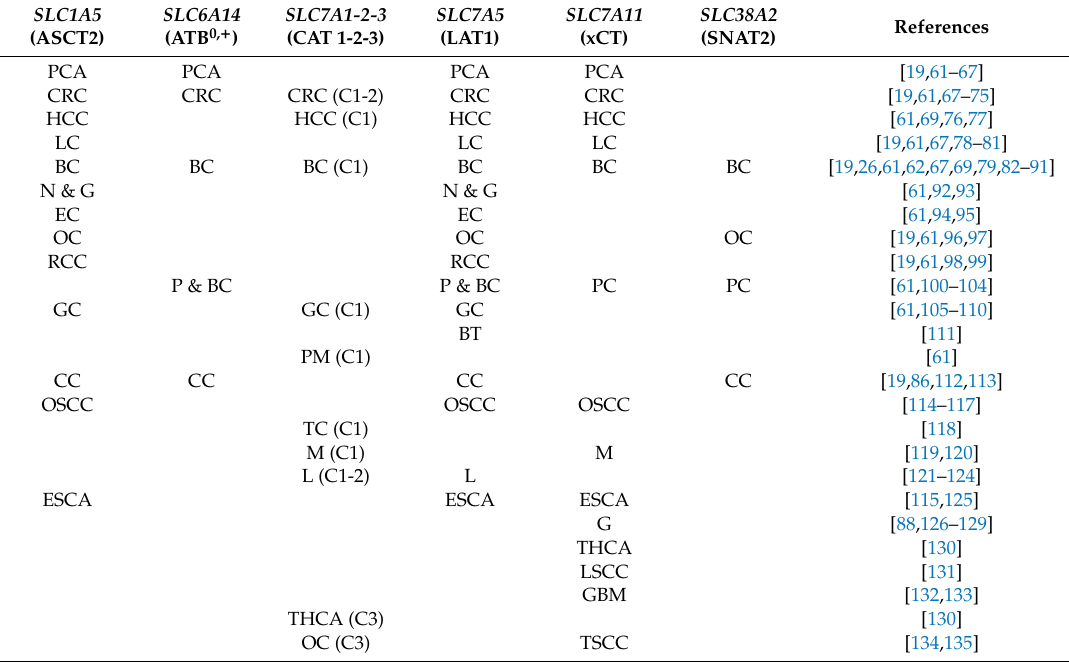
Table 1. Expression of membrane transporters in human